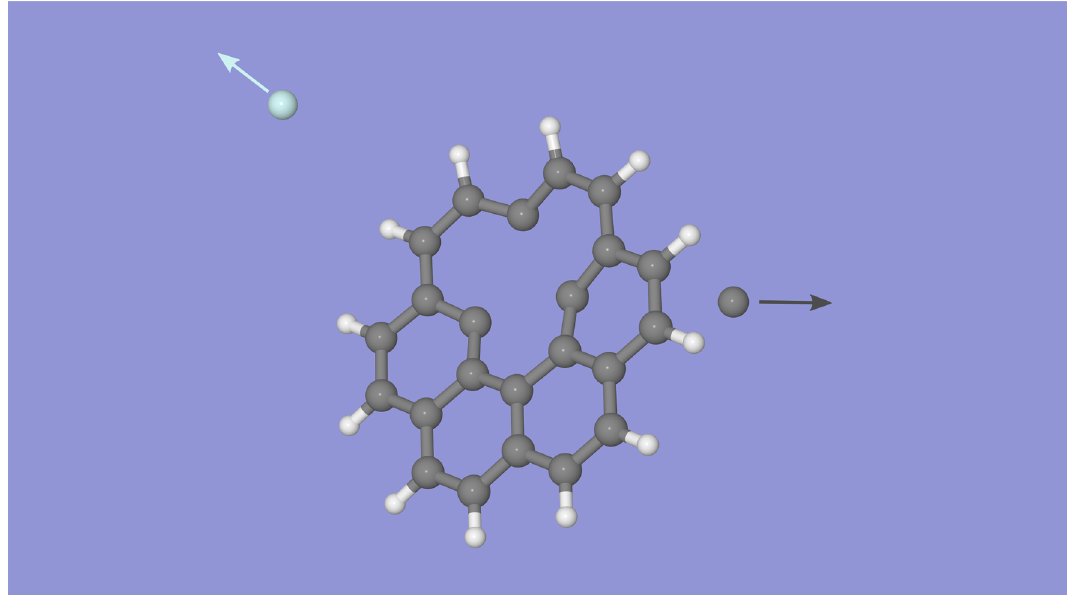
Fig. 7 Snapshot of a simulated collision between He and coronene. This frame shows the positions 35 fs after the start of the simulation (about 25 fs after the collision). The He projectile was fi red from the left and has removed a single C atom from the PAH molecule and is now back-scattered. About 6 eV of internal energy is transferred to the C 23 H 12 fragment in this particular collision. Supplementary Movie 1 shows the fi rst 100 fs of the simulation in steps of 0.5 fs. A total of 10 5 simulations with random orientations of the molecule and with randomized projectile trajectories were performed in the present pressure of about 10 − 14 mbar 40 . In the present experiments, only a single storage ring was used, as shown in Fig. 6. Coronene powder (99.9% purity from Sigma Aldrich) was heated in an oven operating at about 230°C, and the coronene vapor was fed into the plasma of an Electron Cyclotron Resonance (ECR) ion source. Ions extracted from the source were accelerated to 8keV and chopped into pulses matching the length of the storage ring. Coronene cations were mass-selected using a 102° bending magnet (not shown in Fig. 6). A 7cm long gas cell containing He with a pressure of 1.1×10 − 2 mbar (chosen by optimizing for the knockout yield) was mounted on the beamline in order to produce coronene fragment ions from collision-induced dissociation. The 8keV lab energy of the PAHs together with the He target resulted in collisions with energies in the C 24 H þ 12 + He center-of-mass frame of 105eV. This corresponds to a velocity of Fig. 6 and consists of two electrostatic ion-beam storage rings, each with a racetrack about 72km/s, which is typical for gas in interstellar shocks 24 and stellar winds 54 . All layout and a circumference of 8.68m, enclosed in a single cryogenically cooled fragments exiting the gas cell had close to the same velocity, so their kinetic energies vacuum chamber. The two rings share a common straight section to allow for scaled linearly with their masses. Products from the collision cell (intact ions or merged-beams experiments with interactions of oppositely charged keV ion beams fragments) were mass/energy selected using a 90° electrostatic de fl ector system at close to zero relative velocity. The rings are operated at 13K and with a residual (consisting of 10°, 70°, and 10° de fl ectors in sequence) just prior to the injection of the gas density on the order of 10 4 cm − 3 (mostly consisting of H 2 ), corresponding to a ions into the storage ring. This de fl ector system was also used to measure a fragment